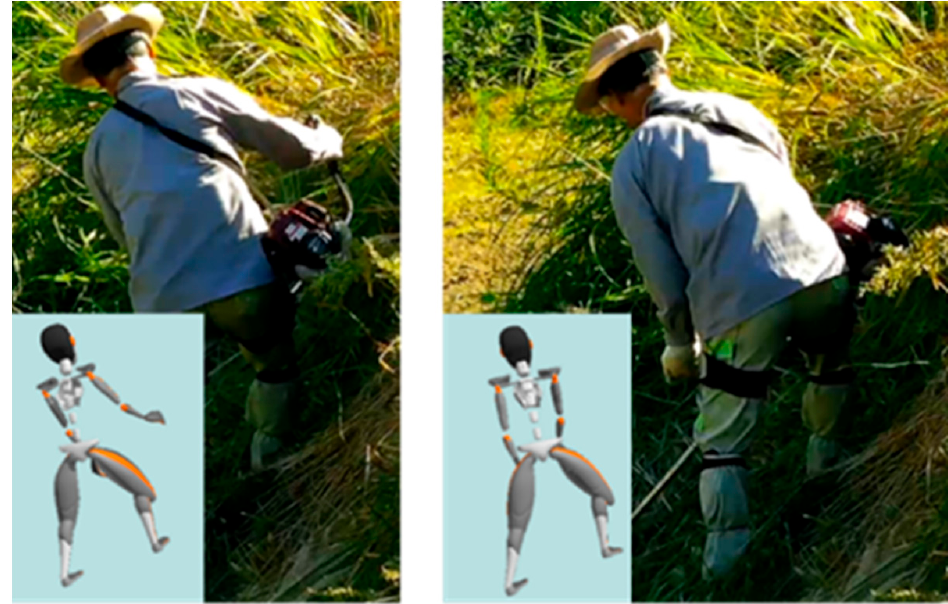
Figure 3. The action of “cutting” on the slope.